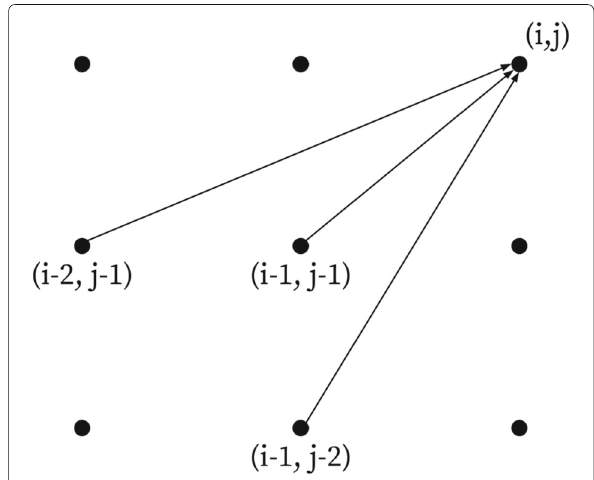
Fig. 4 Transitions allowed in the S-DTW search of the D-ELiRF-UPV-Posteriorgram+DTW-based QbE STD system